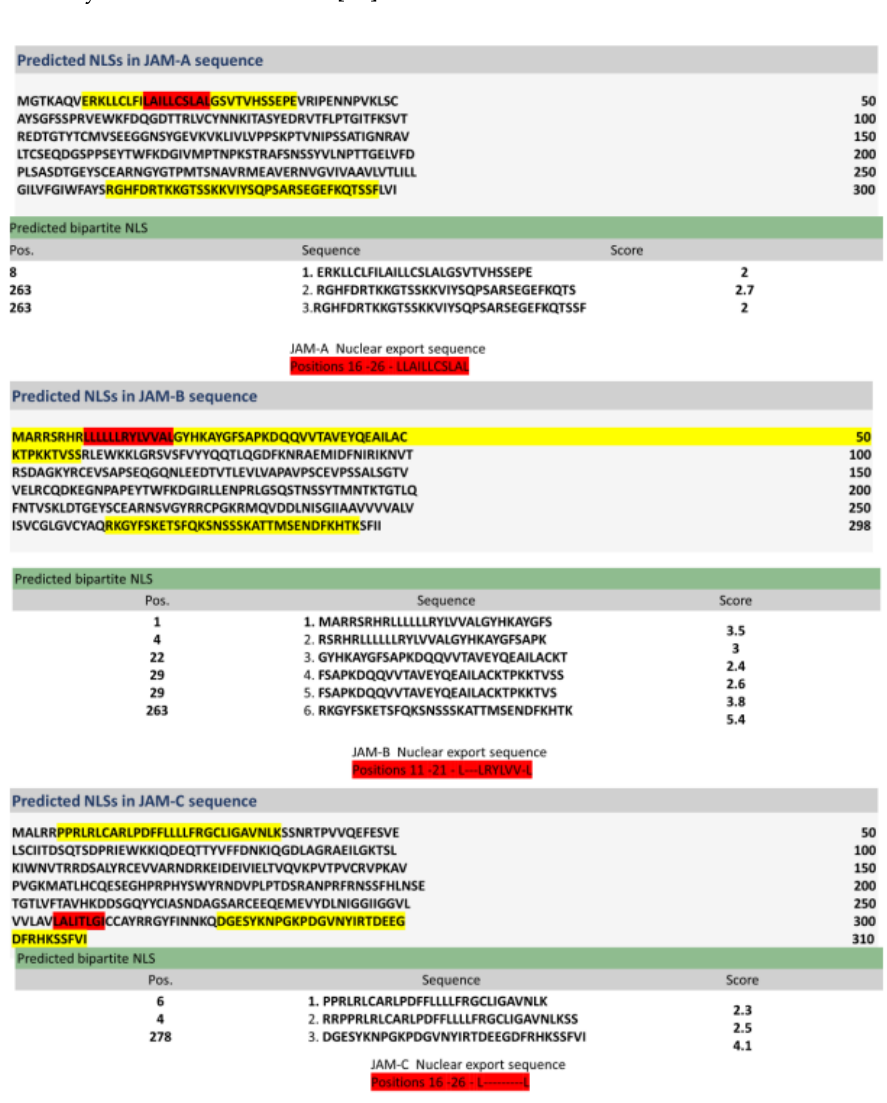
Figure 6. Nuclear localisation and export signals for the junctional adhesion molecules.